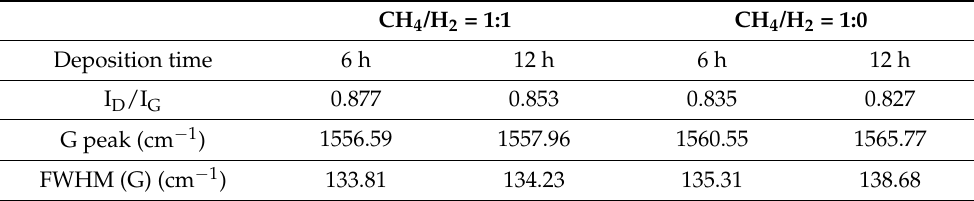
Figure 7. Raman spectrum of DLC film-coated titanium with various deposition conditions. Table 2. Raman features, i.e., I D /I G ratio, G peak position and FWHM (G) of DLC films. CH 4 /H 2 =